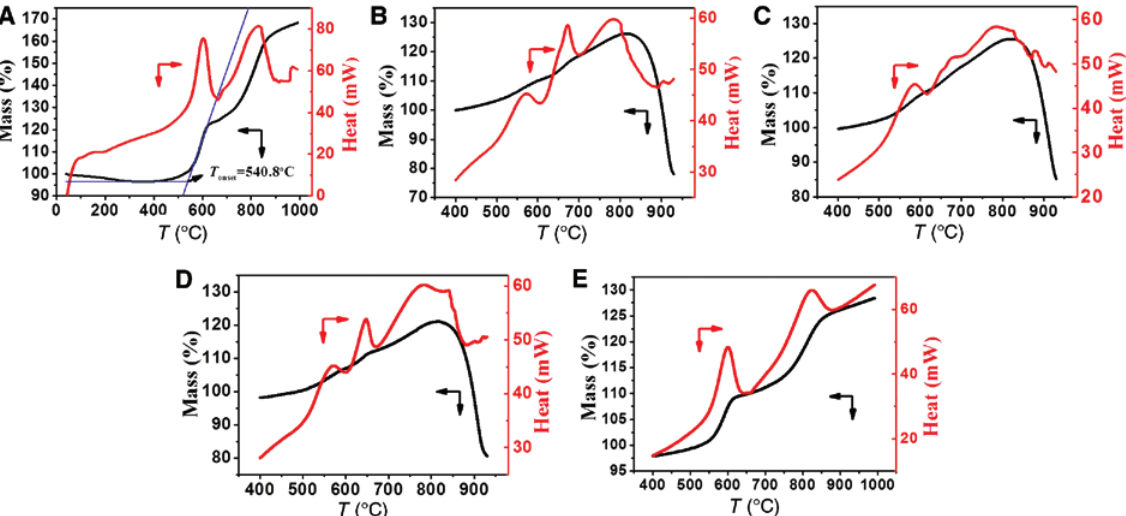
Figure 5: TGA/DSC curves of 100 nm Al and composite thermites: (A) 100 nm Al-NPs, (B) Mo-Al-0, (C) Mo-Al-1, (D) Mo-Al-2, and (E)